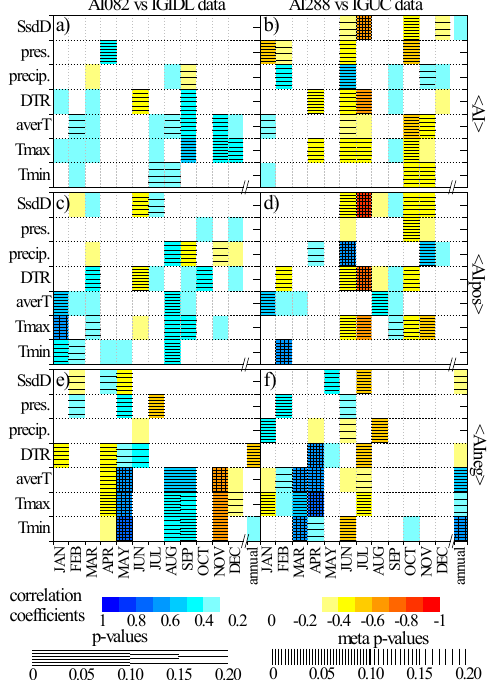
Figure 4. Correlation coefficients ( r) between the AI indices ( (cid:104) AI (cid:105) – a, b ; (cid:104) AIpos (cid:105) – c, d ; (cid:104) AIneg (cid:105) – e, f ) for sites ID 082 (a, c, e) and ID 288 (b, d, f) and atmospheric parameters measured in Lisbon (IGIDL series – a, c, e ) and Coimbra (IGUC series – b, d, f ). Only correlation coefficients | r | ≥ 0 . 3 are shown. The statistical signif- icance for singular ( p values) and multiple (meta p values) com- parisons are shown by shading. All correlation coefficients are cal- culated in a way that in case of simultaneous increase/decrease of the amount of any type of aerosols (changes of an absolute value of any AI index) and an atmospheric parameter value the correlation coefficient is